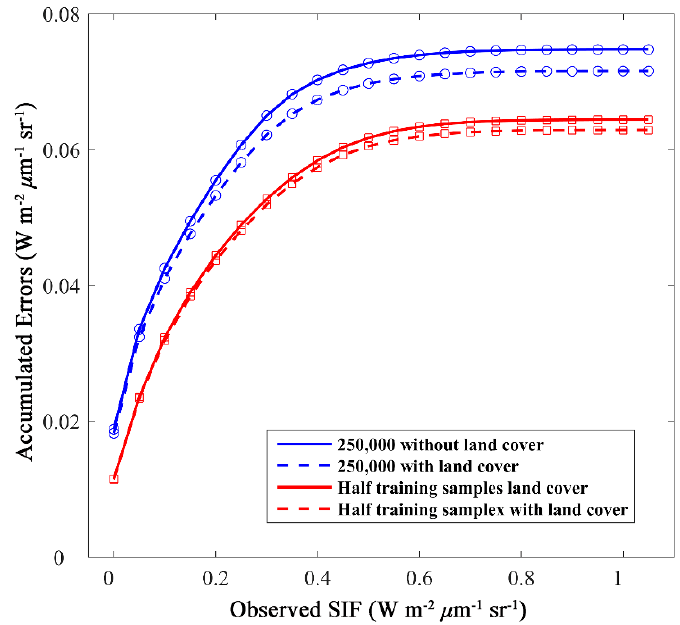
Figure 3. The accumulated errors of predicted SIF by different models: ( a ) Using 250,000 training samples without land cover type, ( b ) using 250,000 training samples with land cover type, ( c ) using half of the training samples without land cover type, and ( d ) using half of the training samples with land cover type.